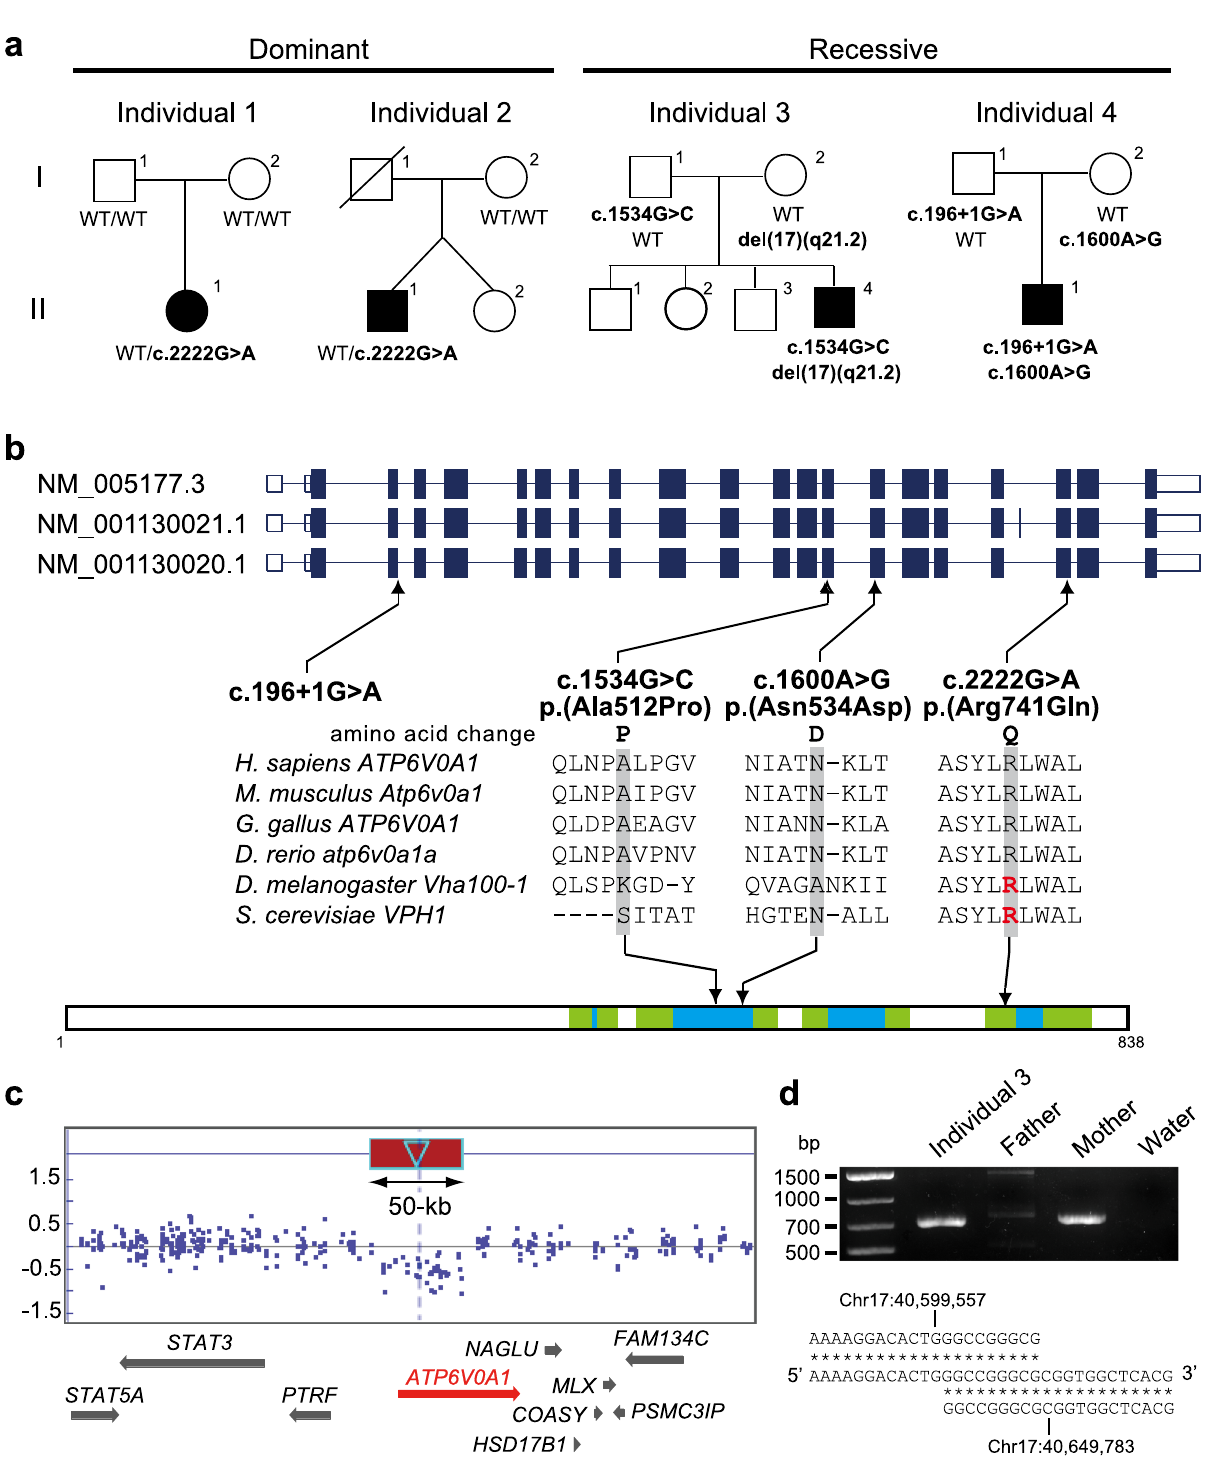
Fig. 1 De novo and biallelic variants in ATP6V0A1 in individuals with DEE. a Familial pedigrees of four individuals with ATP6V0A1 variants. The segregation of each variant is shown. b ATP6V0A1 transcripts (UTR and coding region are open and fi lled rectangles, respectively). Three transcripts are registered in the RefSeq database, and all four variants are involved in common exons of the three transcripts. Human ATP6V0A1 is 838 aa in length (NP_001123492.1 from NM_001130020.1) and contains nine putative transmembrane domains according to UniProt (Q93050). Amino acids located at the cytoplasmic and vacuolar sides and in the transmembrane domain are shown in white, sky blue, and green, respectively. The multiple sequence alignment was performed via the CLUSTALW website (https://www.genome.jp/tools-bin/clustalw) using the following sequences: NP_001123492.1 ( Homo sapiens ), NP_058616.1 ( Mus musculus ), NP_990055.1 ( Gallus gallus ), NP_997837.1 ( Danio rerio ), NP_651672.1 ( Drosophila melanogaster ), and NP_014913.3 ( Saccharomyces cerevisiae ). Arg735 in VPH1 and Arg755 in VHA100-1, which are essential for proton transport, are highlighted in red. c A 50-kb deletion involving ATP6V0A1 in individual 3 detected by cytogenetics whole-genome 2.7M array. The deleted region is indicated by a red box. d Breakpoint-speci fi c PCR and sequencing con fi rmed the 50-kb deletion (chr17: 40,599,557 – 40,649,783), which was transmitted from his mother. Top, middle, and bottom strands show proximal, recombined, and distal sequences, respectively. A total of 9-bp sequences were overlapped in the proximal and distal breakpoints. Data in d are representative of two independent experiments. NATURE COMMUNICATIONS| (2021) 12:2107 |https://doi.org/10.1038/s41467-021-22389-5|www.nature.com/naturecommunications